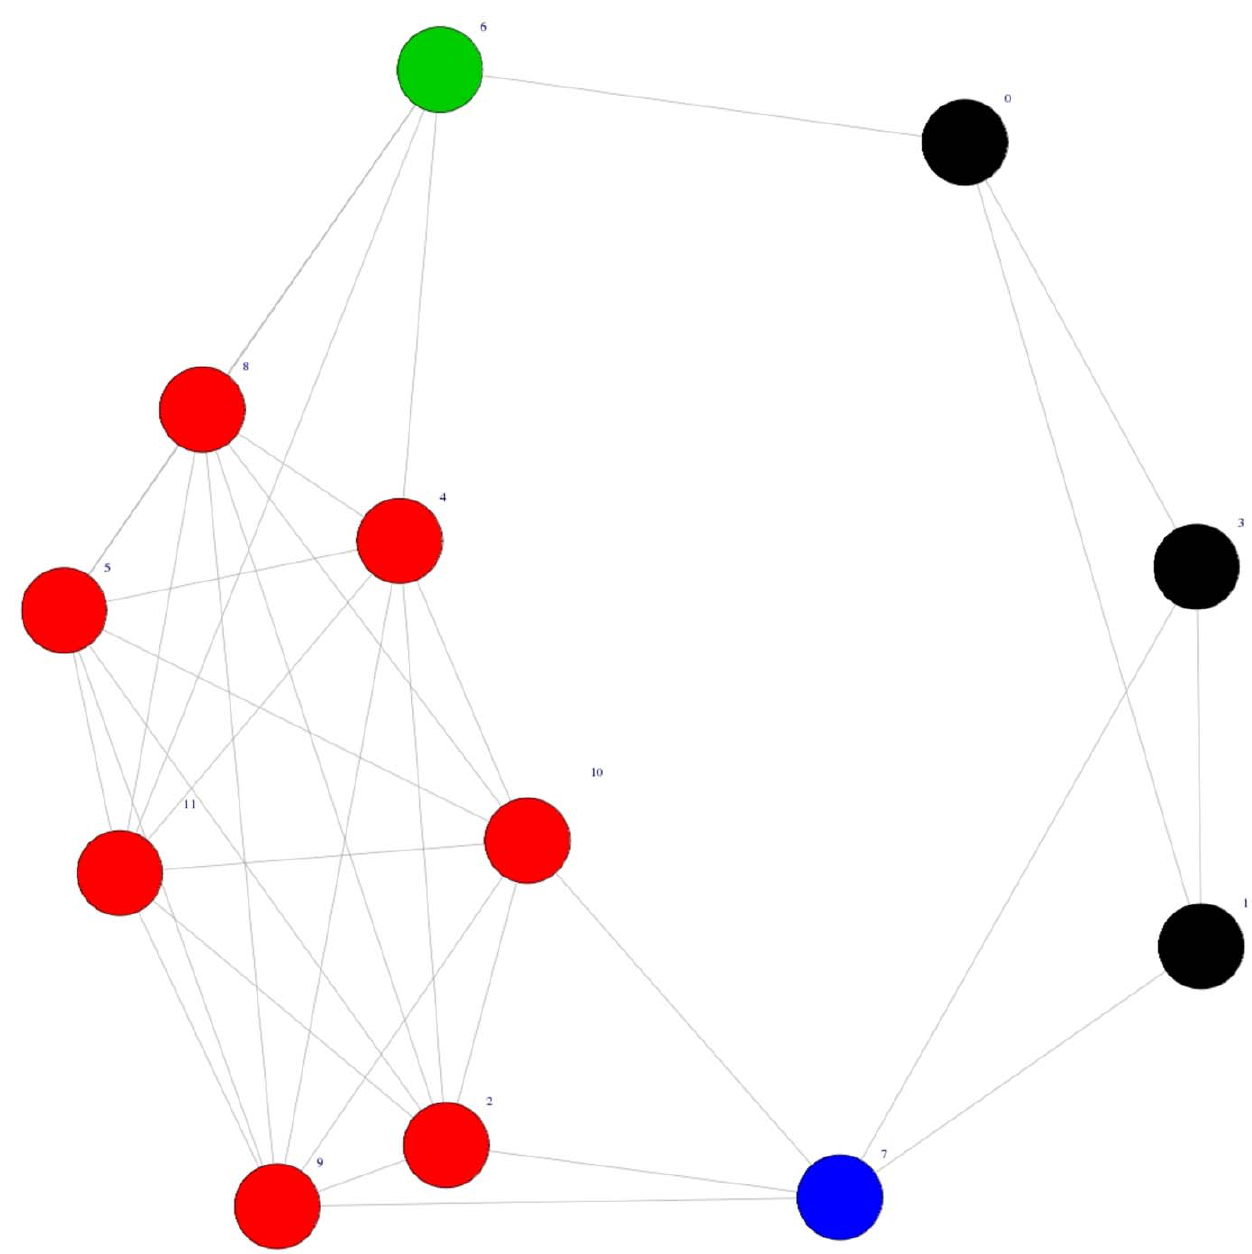
Figure 1. NetSe l network on the real dataset. The relative exctracted communities are C1(black dots), C2 (red dots) and the two outliers variables C4 (blue dot) and C3 (green